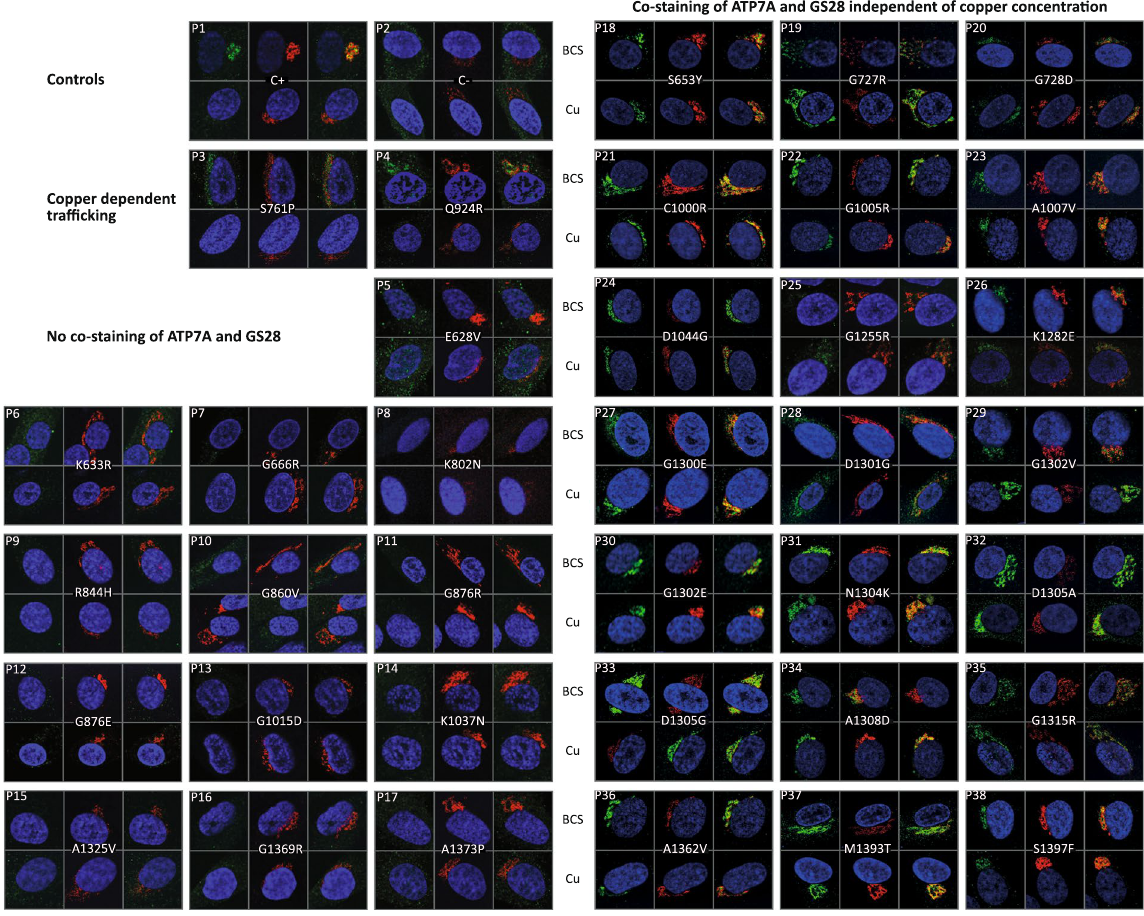
Figure 3. Cellular investigation of endogenous ATP7A protein in MD fibroblasts by indirect immunofluorescence (IF). MD fibroblasts with various missense mutations were stained with primary antibodies against ATP7A (green; position 1) and the Golgi specific marker GS28 (red; position 2), respectively. Also a merge picture is shown (position 3). The nuclei were counterstained with DAPI. Copper-dependent trafficking was investigated in the presence of BCS (upper panel) and CuCl 2 (lower panel), respectively. The pictures are divided into groups defined by the effect of the mutation on cellular location of the ATP7A protein. P1: Normal control cells (C + ). P2: ATP7A negative control cells (C − ). P3–P4: Copper dependent trafficking. P5-P17: No ATP7A signal was detected. P18–P38: Hampered copper-induced trafficking from